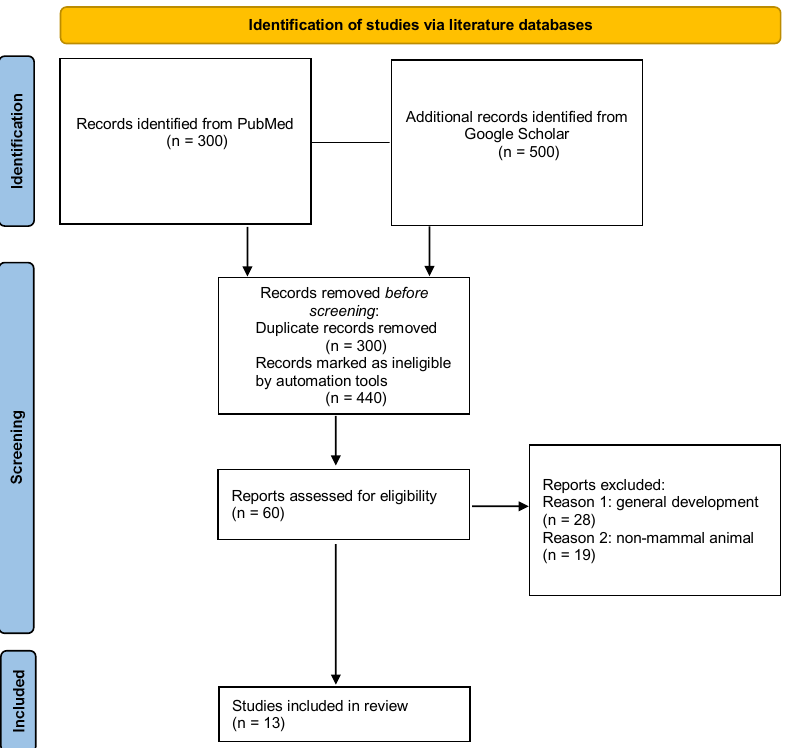
Figure 1. Schematic illustration of the PRISMA flowchart used in the present review. Relevant articles describing the effects of prenatal stress on fetal and child bone development were manually examined, and genotypic, phenotypic, and functional data were extracted for analysis. After the removal of duplicate records, the main results of this search were included in the present reference list and summarized in Table